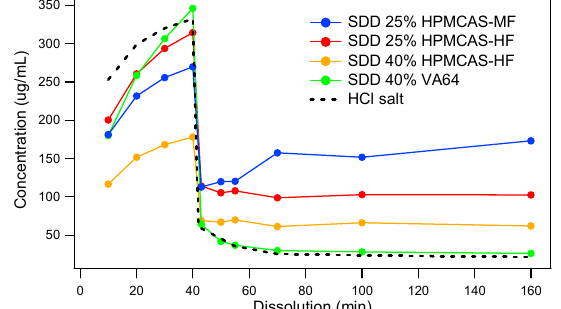
Figure 2. Two-stage dissolution of MK-A solid dispersions prepared by spray drying.